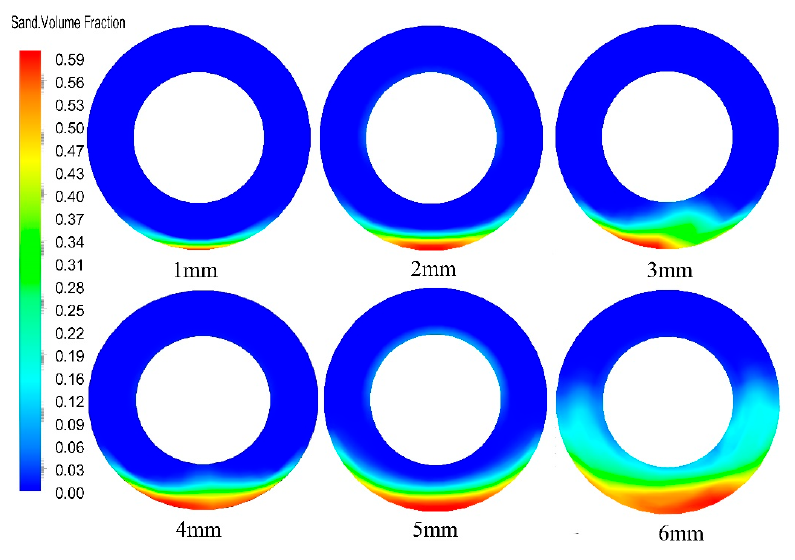
Figure 15. The contour of the effect of particle size on the volume fraction.